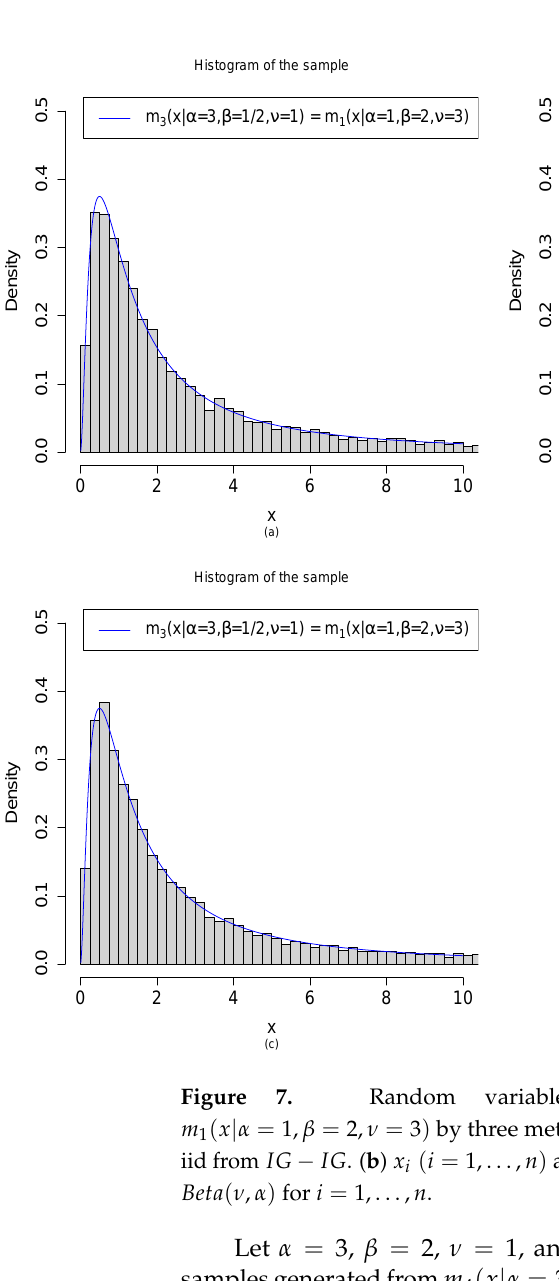
Figure 7. Random variable generations from m 3 ( x | α = 3, β = 1/2, ν = 1 ) = m 1 ( x | α = 1, β = 2, ν = 3 ) by three methods with α = 3, β = 1/2, and ν = 1. ( a ) x i ( i = 1, . . . , n ) are iid from IG − IG . ( b ) x i ( i = 1, . . . , n ) are iid from (cid:102) IG − G . ( c ) x i = ( 1/ z i − 1 ) β , where z i are iid from Beta ( ν , α ) for i = 1, . . . , n